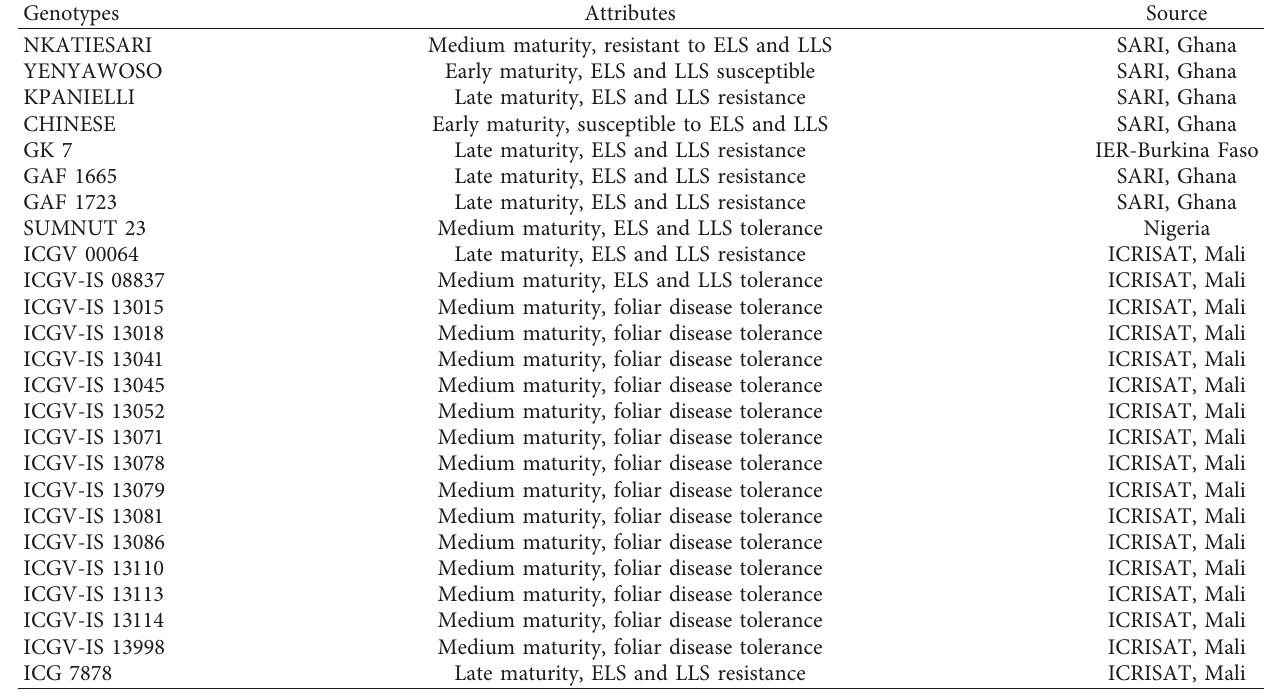
Table 1: Genotypes used in the study and their characteristics and sources where they were obtained.